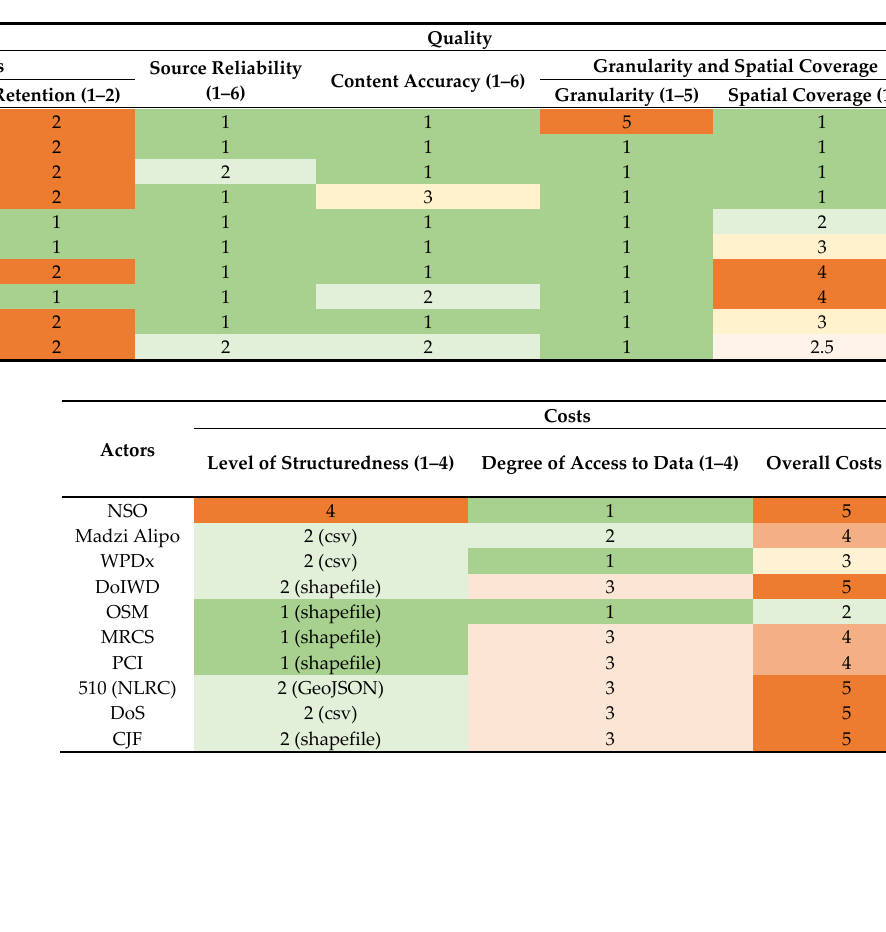
Table 4. Data supply dimension: quality (top) and costs of extraction (bottom) of the data sets of the main actors in the WASH data ecosystem. Colours are assigned per column, shaded from green (good) up to brown ‐ red (poor) divided over the range of the scoring. For overall cost and quality, the minimum and maximum scores in the column are used.